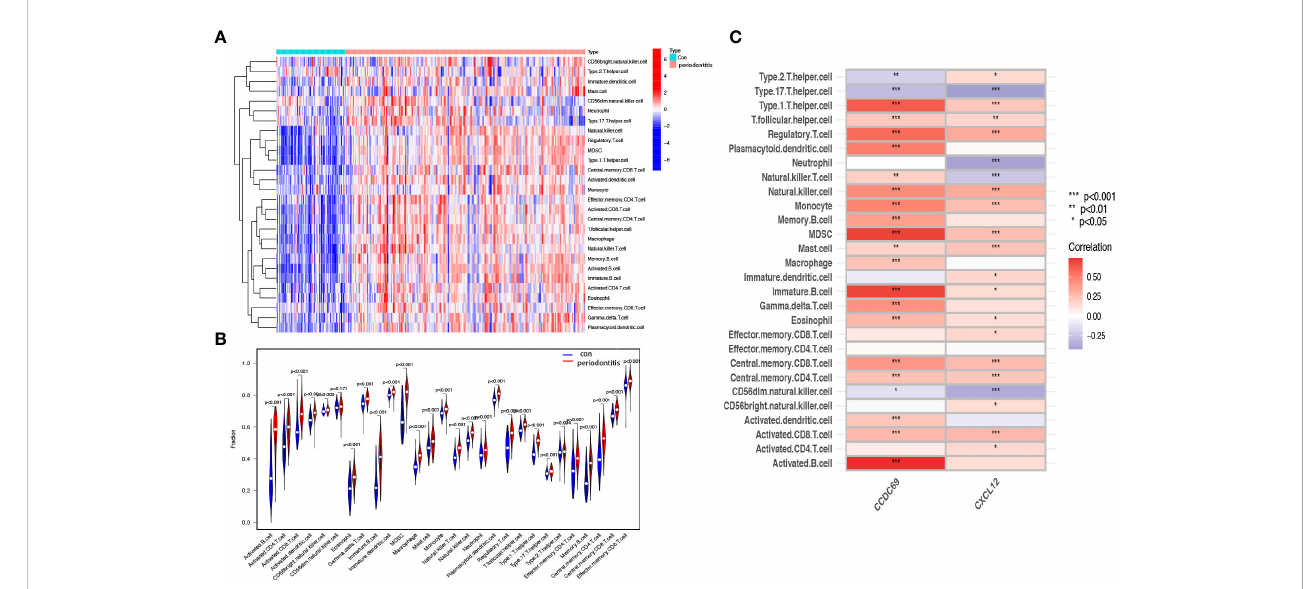
FIGURE 7 Analysis of immune in fi ltration associated with periodontitis. Heat (A) and violin plot (B) showing the distribution of 28 immune cells in the GSE16134 sample. (C) The relationship between diagnostic genes and immune cell in fi ltration. Con, control.